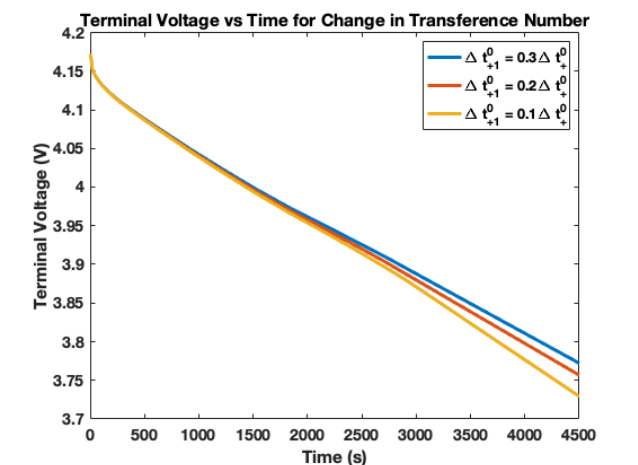
Figure 12. Terminal voltage vs. time for change in transference number from 0.3 to 0.1.